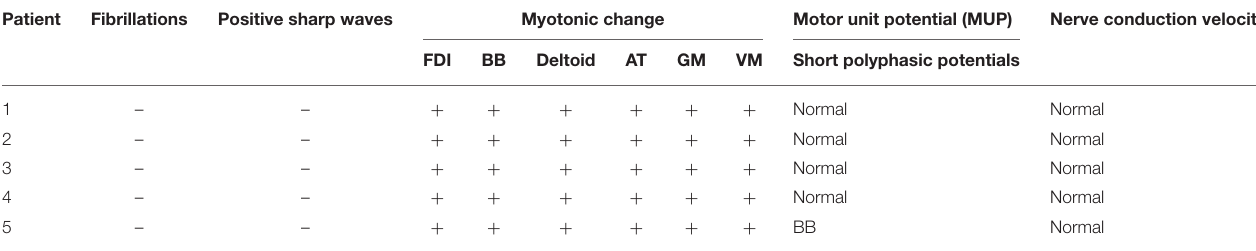
FDI, first dorsal interosseus; BB, Biceps brachii; AT, tibialis anterior muscle; GM, gastrocnemius; VM, vastus medialis.